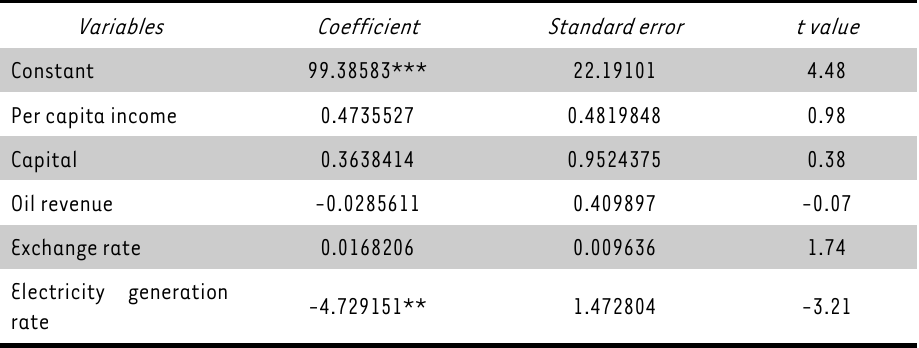
Fixed effects (within variation regression) estimation results for